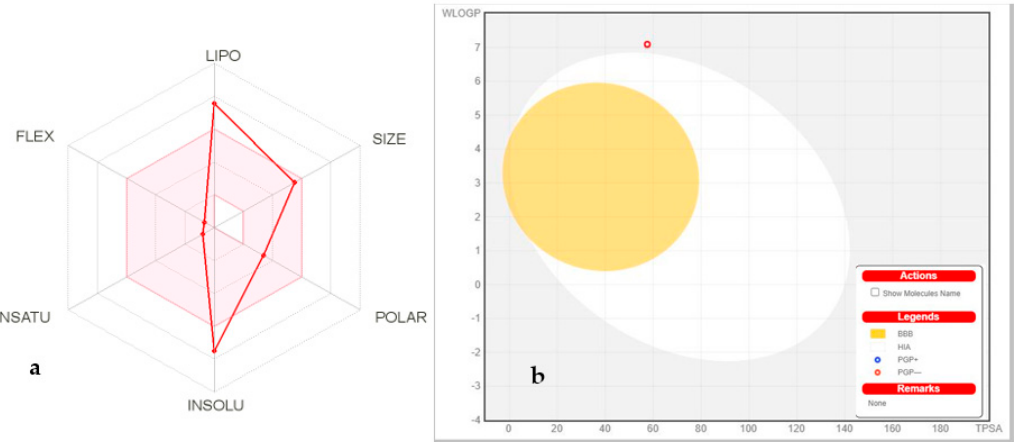
Figure 6. ( a ) Bioavailability radar chart for NA. The pink zone represents the physicochemical space for oral bioavailability, and the red line represents the oral bioavailability properties. ( b ) Predicted BOILED-Egg plot from swiss ADME online web tool for NA.